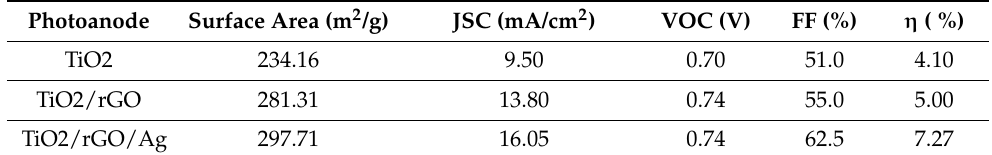
Figure 4. ( a ) Current density–voltage characteristics (with error bar), ( b ) IPCE spectra for different photoanode-based DSSC devices (mesosphere TiO 2 , TiO 2 /rGO and TiO 2 /rGO/Ag) measured under one sun illumination, ( c ) compared efficiency of recent reported photoanode materials with TiO 2 /rGO/Ag device performance, ( d ) schematic representation of the charge transfer process influ- enced by a plasmonic hybrid nanostructure (TiO 2 /rGO/Ag)-based DSSC device and ( e ) DSSC device consists of hybrid photoanode and energy level diagram. Table 1. Comparison of the photovoltaic properties and surface area of the DSSC device based on the mesosphere TiO 2 , TiO 2 /rGO and TiO 2 /rGO/Ag photoanodes measured under AM 1.5 G one sun illumination.